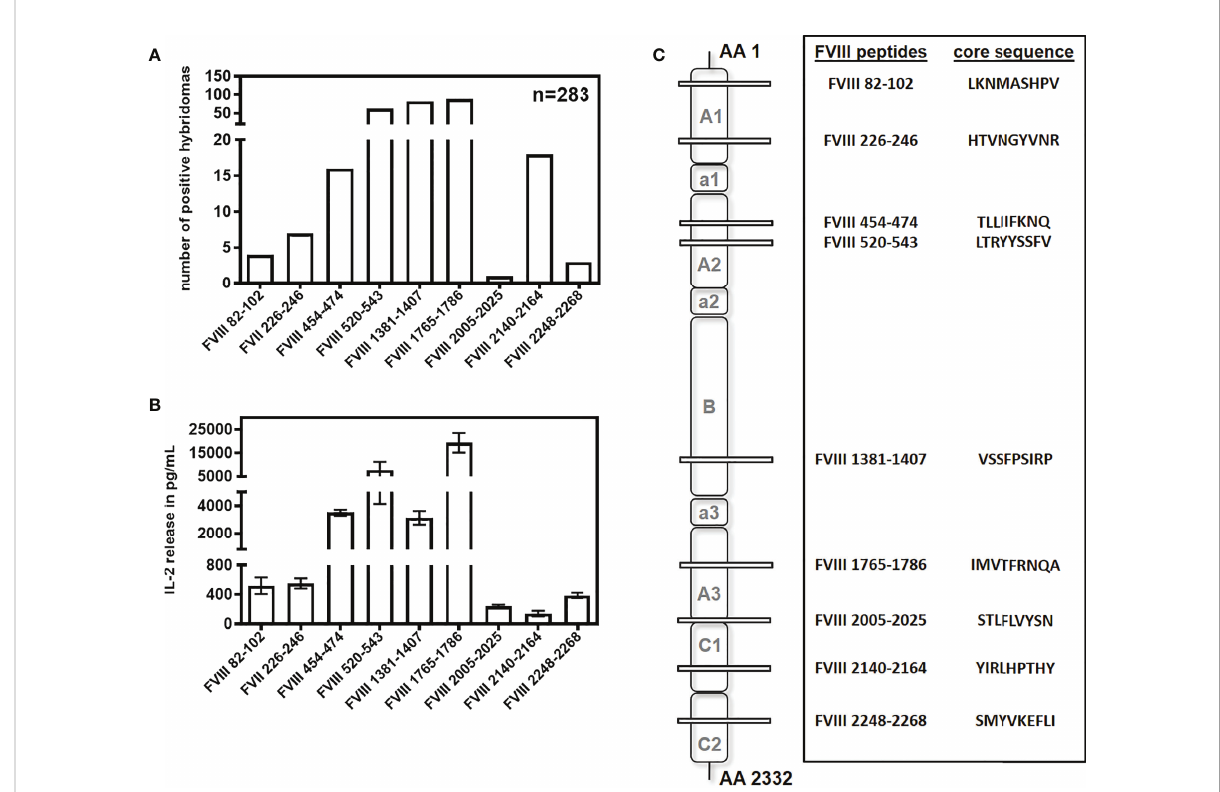
FIGURE 1 Repertoire of CD4+ T cell epitopes after intravenous and subcutaneous application of FVIII in humanized E17 HLA-DRB1*1501 mice. E17 HLADRB1*1501 mice (E17 human MHC class II) received up to 9 weekly intravenous or subcutaneous doses of 1 µg recombinant human full- length FVIII. Spleen cells were obtained 3 days after the last immunization, re-stimulated with either human FVIII protein or a human FVIII peptide pool, and subsequently fused with cells of a BW thymoma cell line as described (32). CD4+ T cell hybridoma clones were characterized for their peptide speci fi city using a 15-mer peptide library (12 amino acids overlap) covering the sequence of full-length human FVIII. (A) Number and peptide speci fi city of CD4+ T cell hybridoma clones obtained from a total of 24 fusion campaigns. (B) Representative examples (n=3) for the IL-2 release of FVIII-speci fi c CD4+ T cell hybridoma clones speci fi c for different FVIII peptide regions during incubation with 10U FVIII. Presented is the mean value ± SD. (C) Core sequences, peptide speci fi cities and associated FVIII domains of the CD4+ T cell hybridoma clones described in (A)